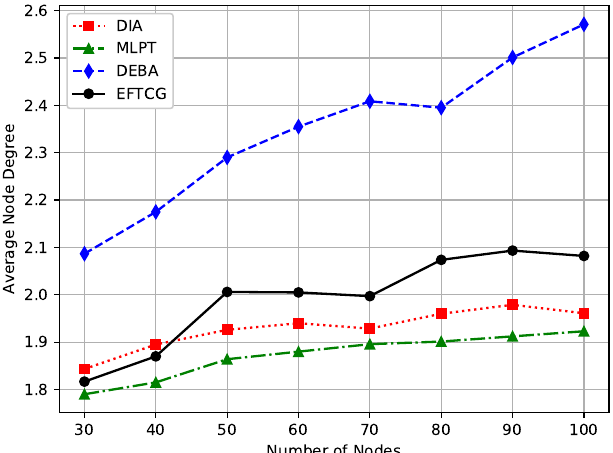
Figure 7. The comparison of the average node degree under different